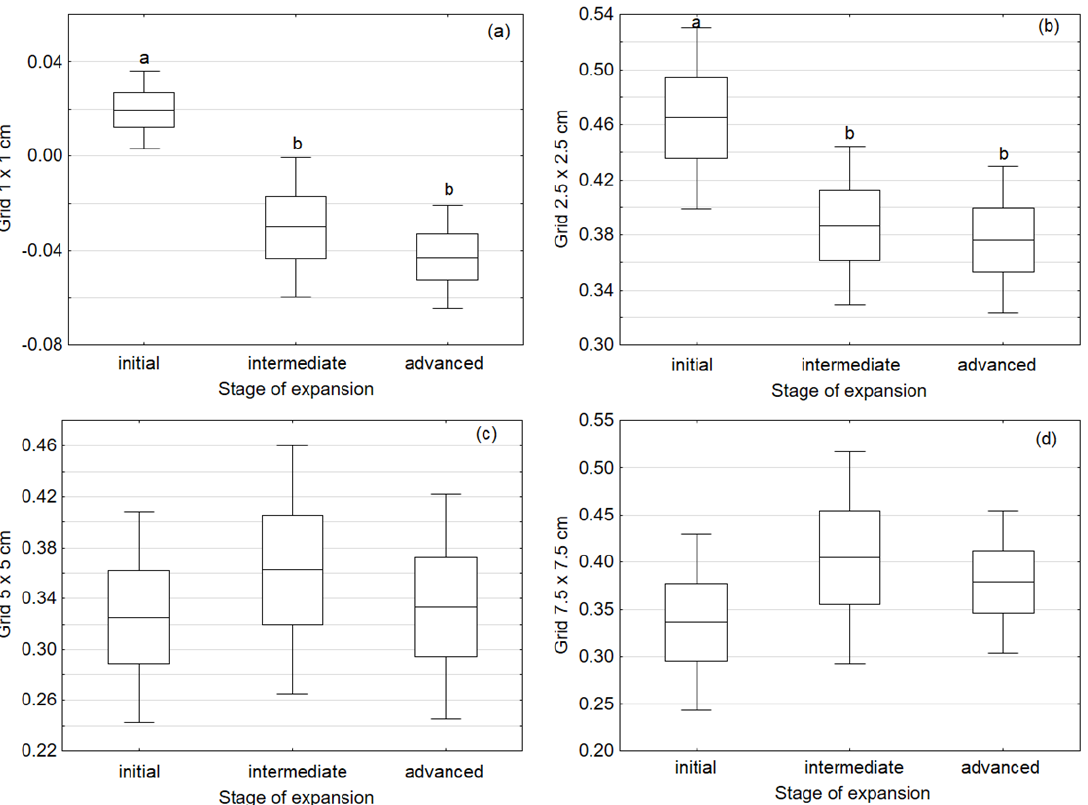
Figure 2. Mean values of Moran’s I coefficient for four resolution scales: 1 × 1 cm ( a ), 2.5 × 2.5 cm ( b ), 5 × 5 cm ( c ), and 7.5 × 7.5 cm ( d ). Means with standard error values (boxes) and confidence intervals (whiskers) for plots are given. Different letters indicate significant differences obtained after Tukey ’ s test or the Kruskal – Wallis test ( p ≤ 0.05).